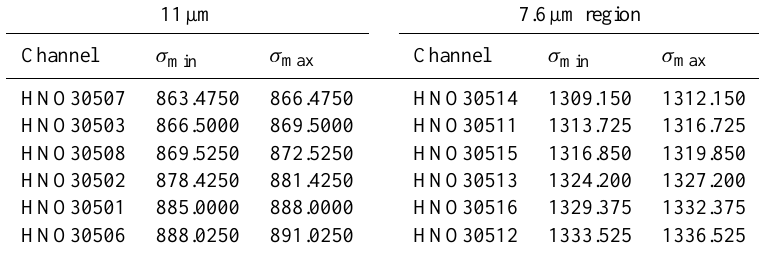
Table 2. Micro-windows used for HNO 3 retrievals at 11 and